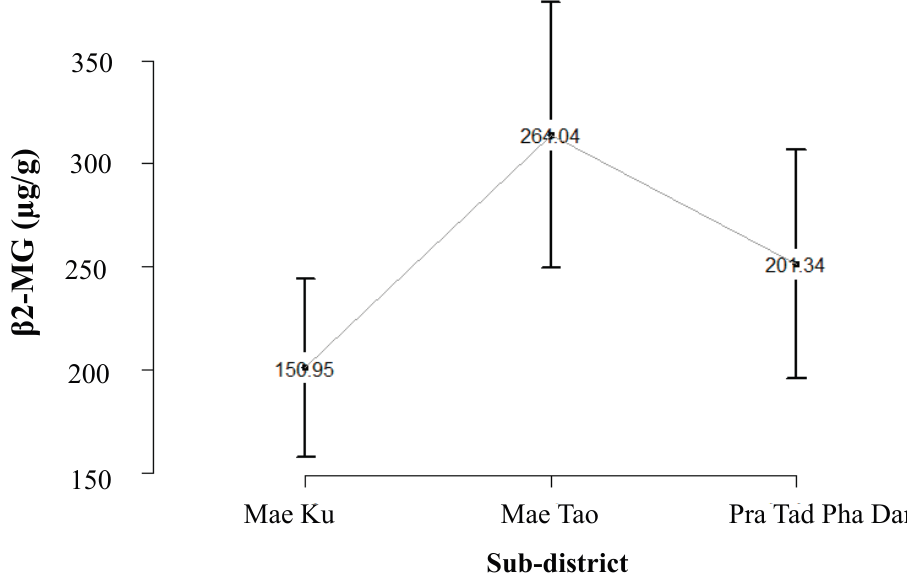
Figure 2. Distribution of β 2 –microglobulin ( β 2 -MG) in surveyed population in Mae Sot areas: residents in Mae Ku (mea n = 150 µg/g creatinine, 95% CI = 108–194), Mae Tao (mean = 264 µg/g creatinine, 95% CI = 199–328), and Pra Tad Pha Dang (mean = 201 µg/g creatinine, 95% CI =